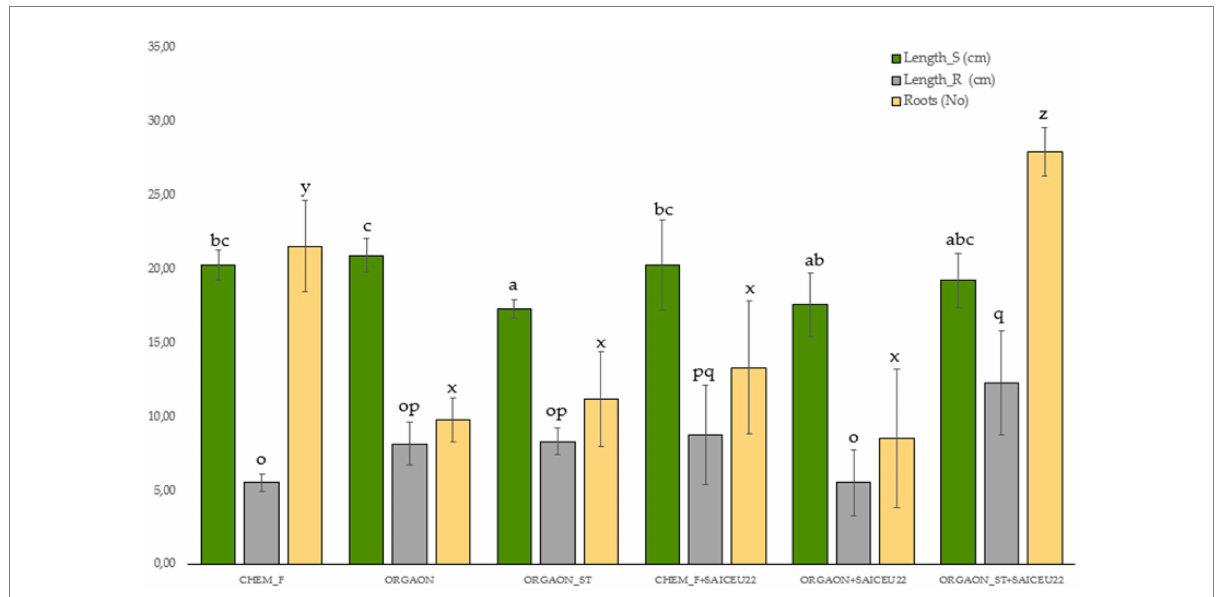
FIGURE 3 Weight biometrics of lupine plants subjected to different irrigation treatments with biofertilizer with SAICEU22 T . Different letters denote statistically significant differences according to Duncan test ( p < 0.05) for shoot length (a, ab, abc, bc, and c), the root length (o, op, pq, and q) and the number of secondary roots ( x , y , and z